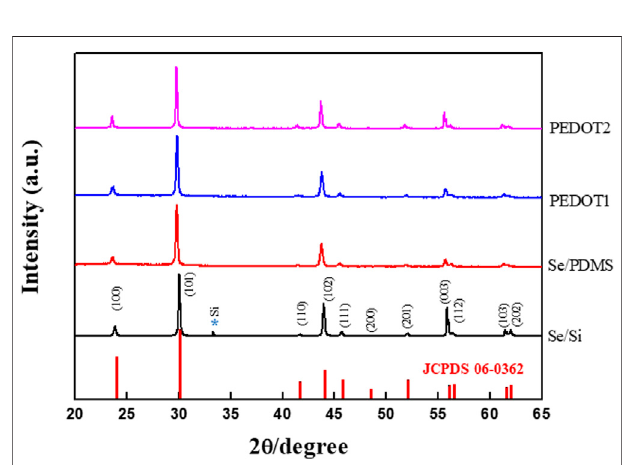
FIGURE4| X-raydiffraction pattern oftheSenanowire structure and Se nanowire:PEDOT. The structure change according to the PSS complex process is con fi